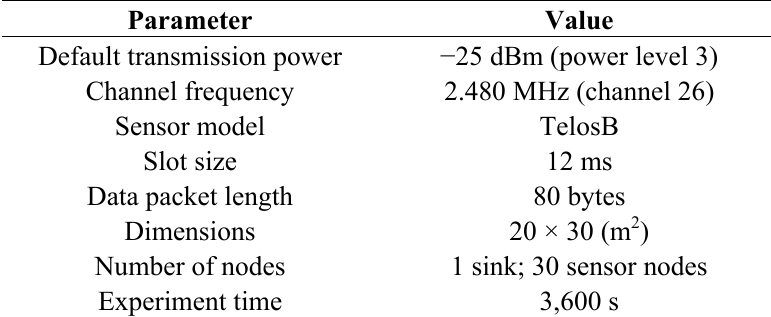
Table 1. RSBP experiment